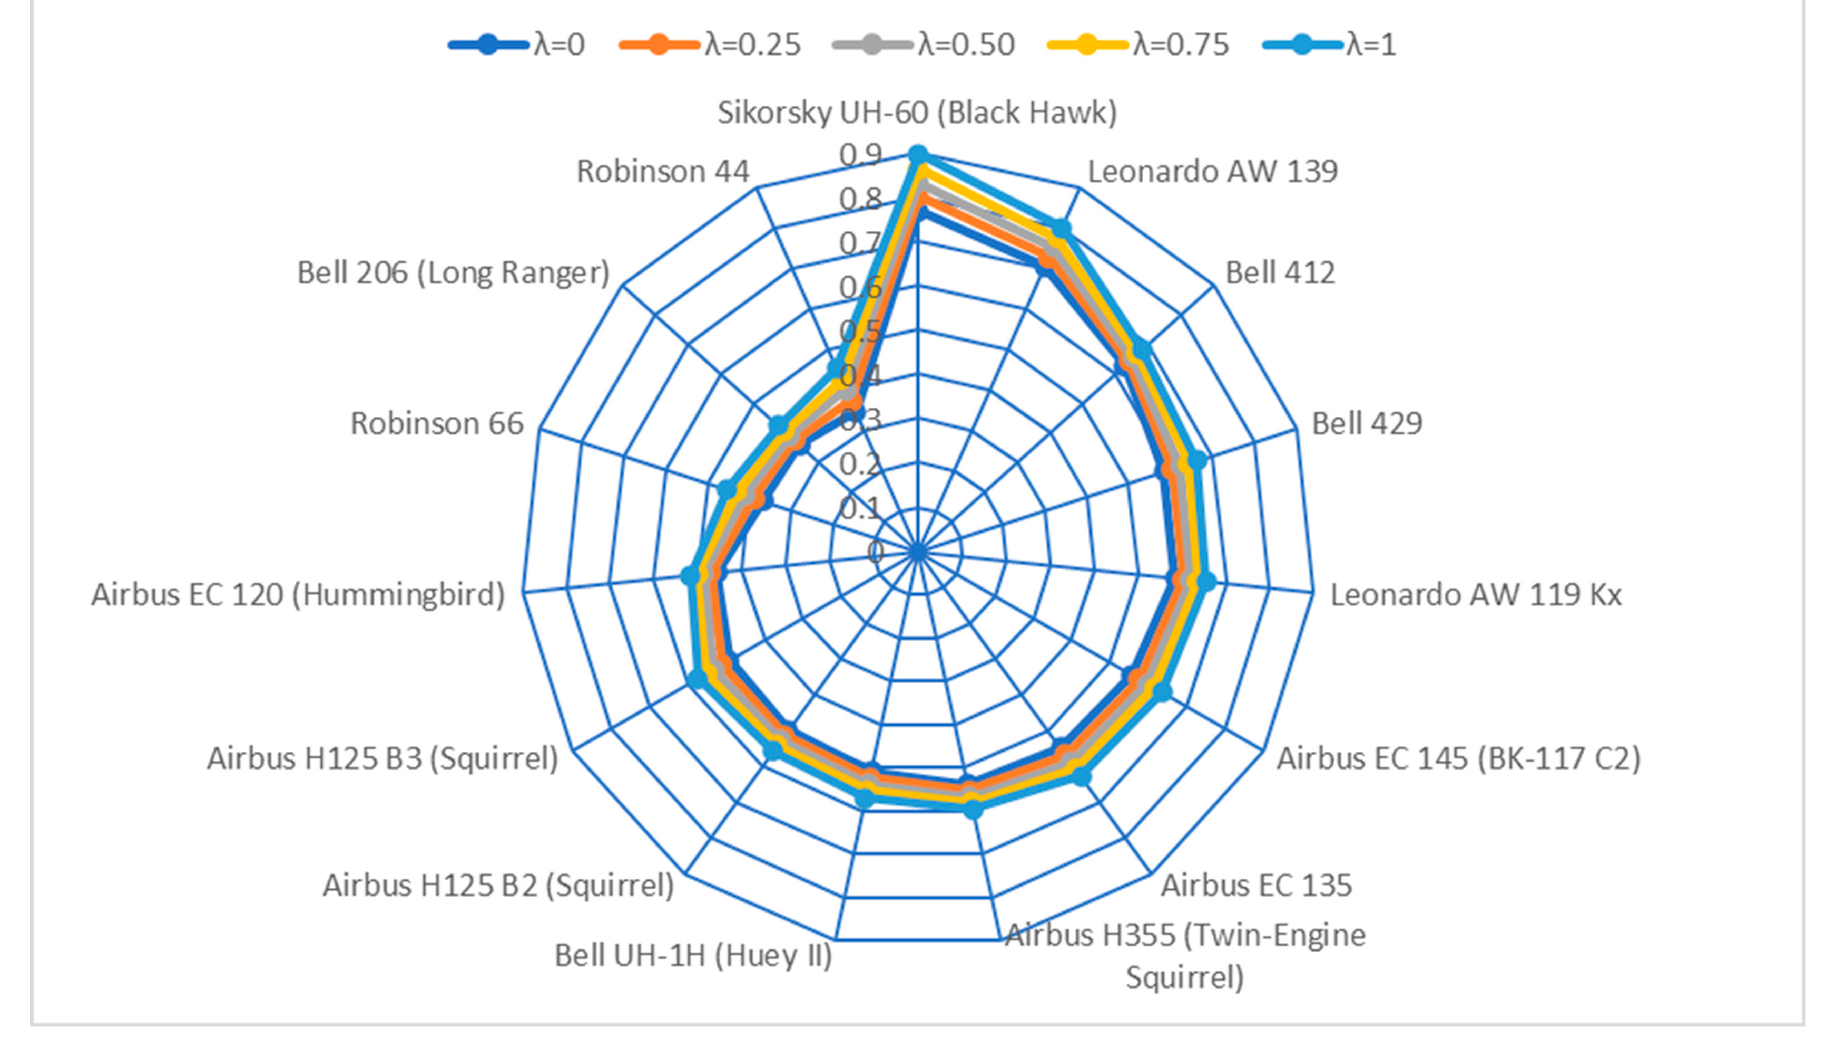
Figure 2. Illustration of the ranking of helicopters with the application of WASPAS.